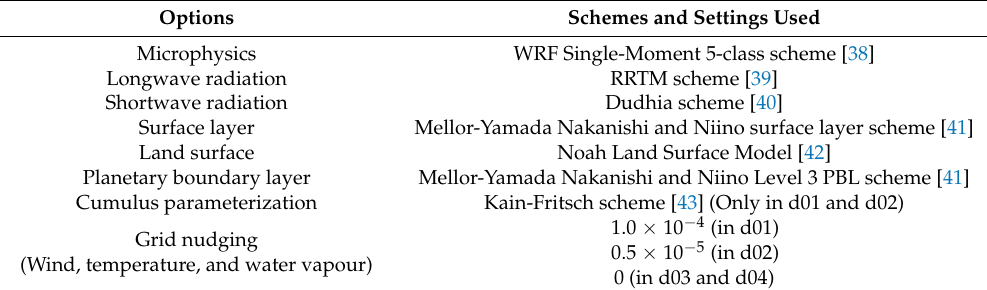
Table 3. Schemes and settings used in the WRF